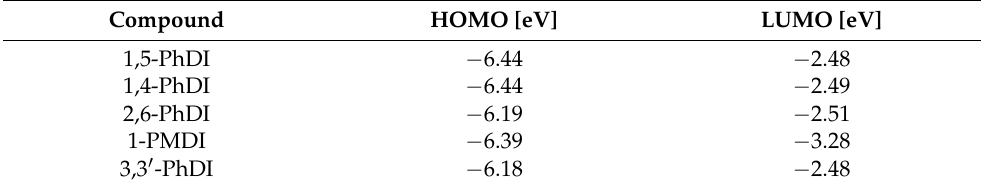
Table 6. Theoretical values of HOMO and LUMO levels.